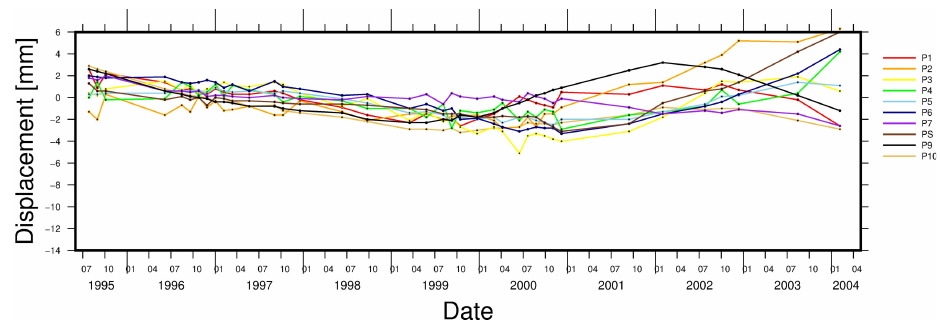
Figure 9. LOS displacements in the 1995–2003 period—ERS-2.